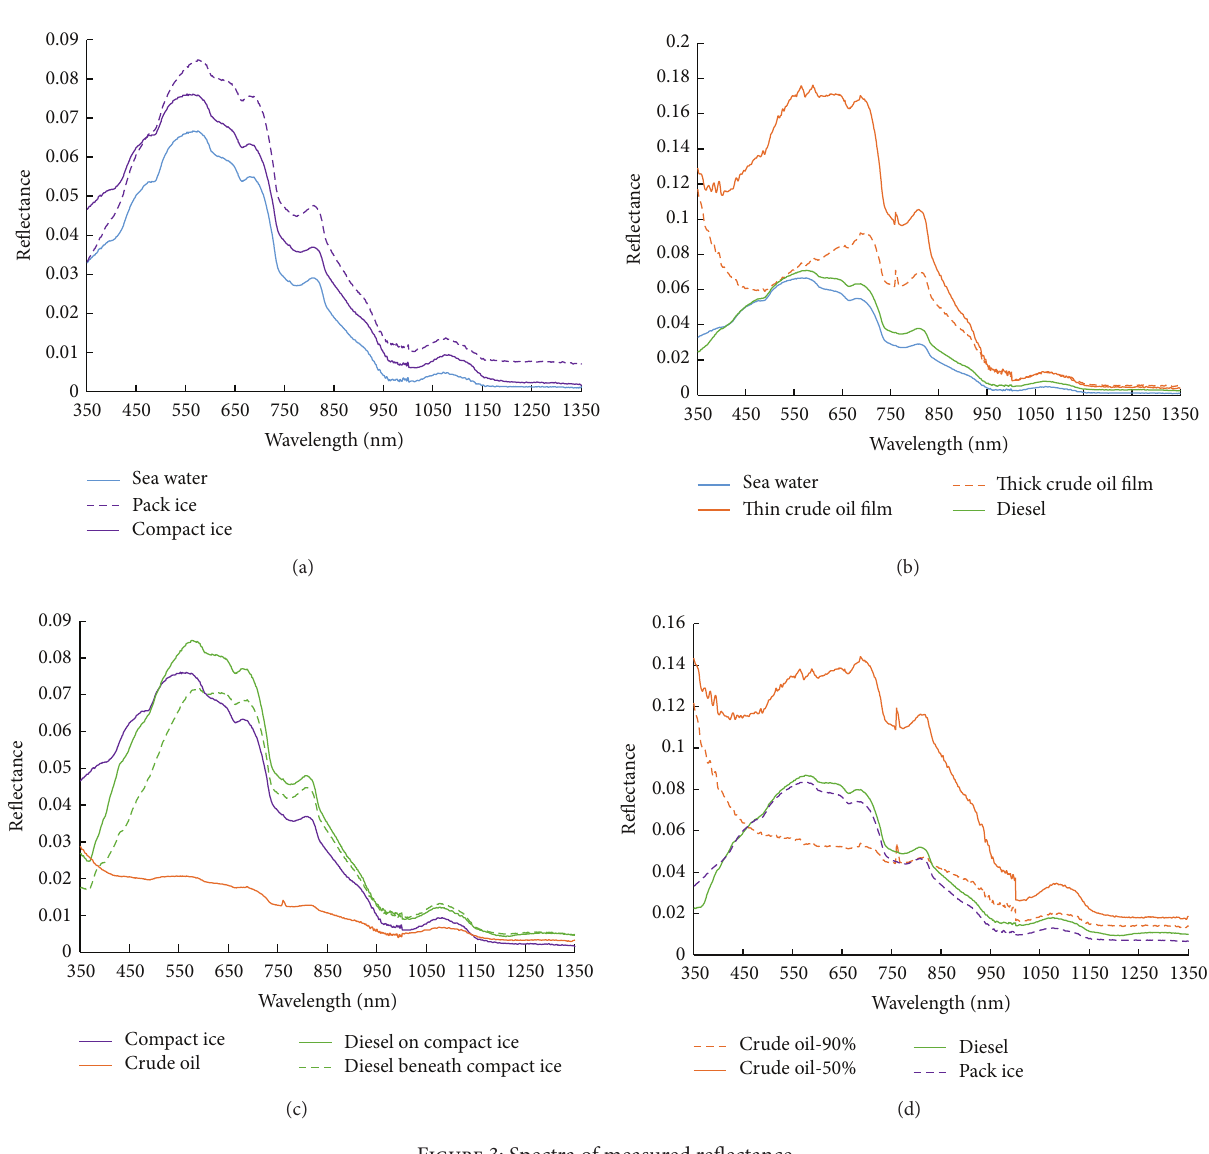
Figure 3: Spectra of measured